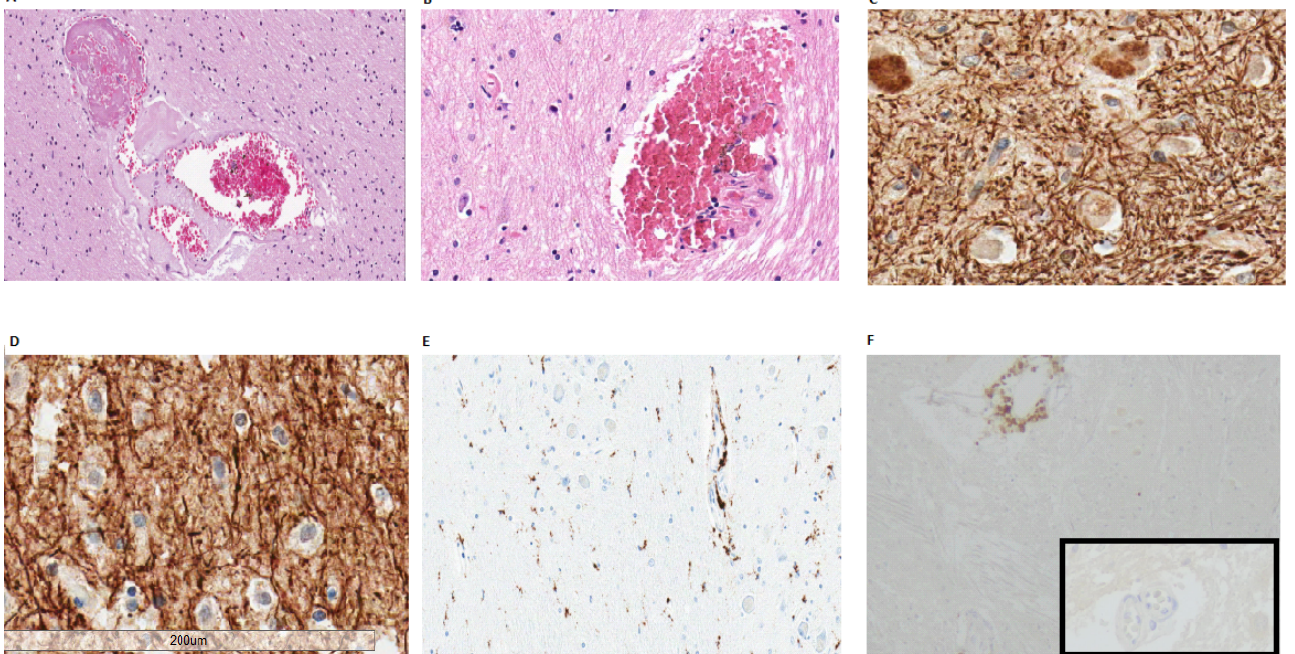
Figure 2. ( A ) Micro-thrombi in small intra-parenchymal vessels (case 28, frontal cortex); ( B ) Micro- hemorrhages surrounding small intraparenchymal of the brain stem (case 13); ( C , D ) Neurofilament staining showed no clear axonal damage in the medulla oblongata ( C ) and in the olfactory tract ( D ) of SARS-CoV-2 positive specimens; ( E ) Microglial activation and perivascular histiocytes were evi- denced by CD68 (case 1). ( F ) Immunostaining for CD4 highlighted sparse perivascular lymphocytes CD4+ (case 4, medulla oblongata). Inset: normal brain parenchymal vessel without inflammation (immunostaining for CD4).